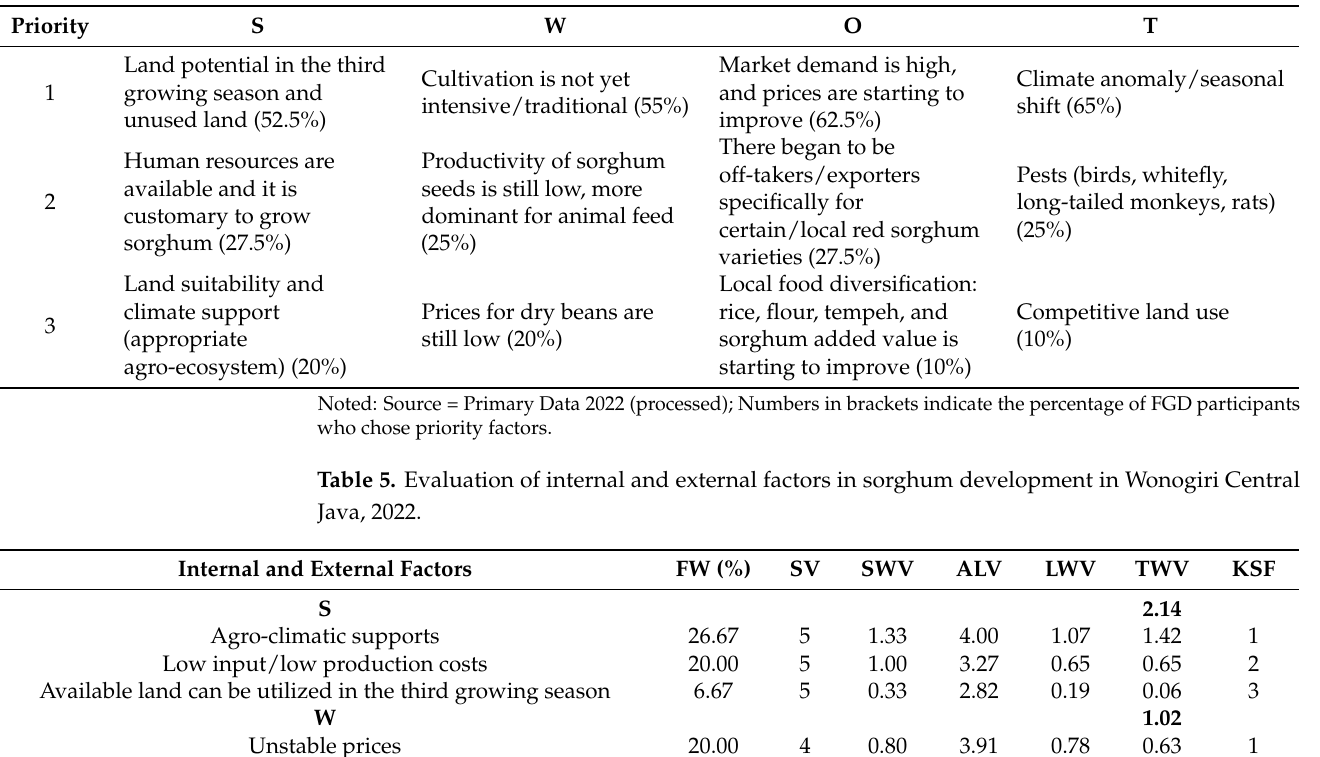
Table 4. Priority factors of SWOT to sorghum development in Gunungkidul Yogyakarta, 2022.